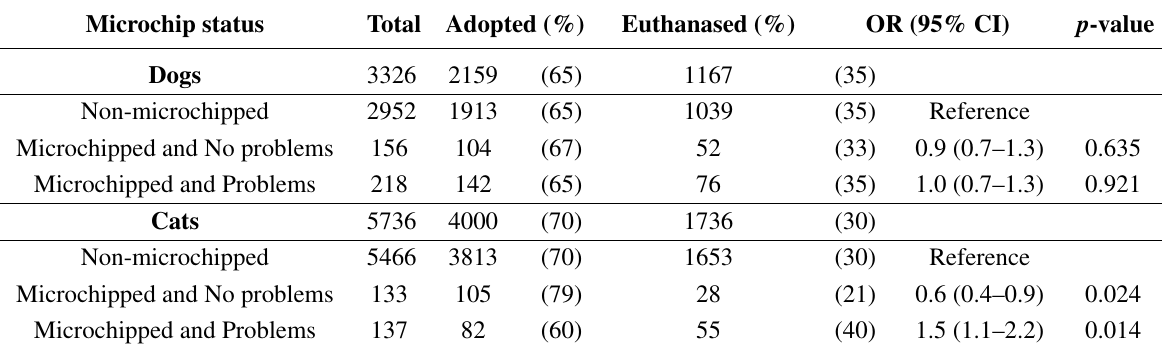
Table 6. Results of logistic regression analyses describing the relationship between microchip status and euthanasia of non-reclaimed ( i.e. , adopted or euthanased) stray adult dogs and cats admitted to RSPCA-QLD shelters (January 2012–December 2013). Percentages for adopted or euthanased status within each microchip status are shown in